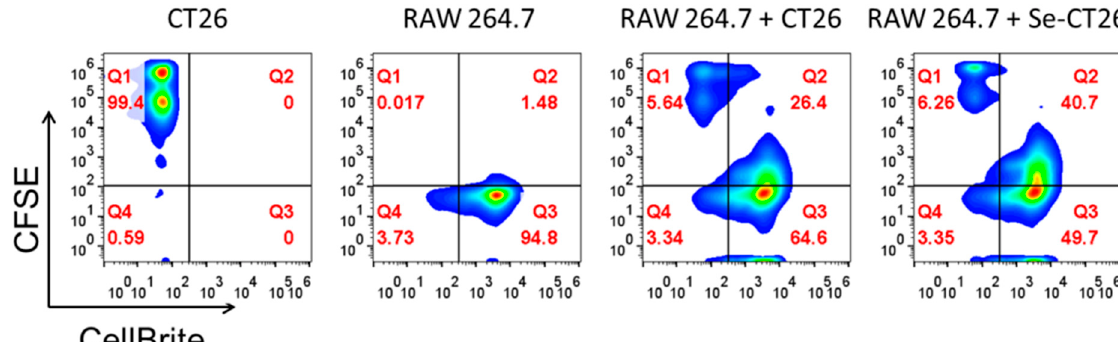
Figure 8. Treatment of CT26 cells with SeNps enhances the phagocytic activity of LPS-stimulated RAW264.7 macrophages against CT26-derived cellular debris. Flow cytometric quantification of phagocytosis of SeNps-treated CT26 cells by RAW264.7 macrophages. CT26 cells were labelled with CFSE prior to SeNps treatment (15 µ g/mL, 48h). Treated CT26 cells and cellular debris were collected and co-cultured for 3 h with LPS-stimulated and CellBrite red-labelled RAW264.7 macrophages (RAW264.7 + Se-CT26). Moreover, RAW264.7 macrophages were co-cultured with the controls, untreated CT26 cells (RAW264.7 + CT26). Cells were collected and analysed on an Attune NxT flow cytometer. CT26 and RAW264.7 cells were also individually analysed (CT26 and RAW 264.7). An enhanced phagocytic activity was observed in macrophages co-cultured with SeNps-treated CT26 cells when compared to macrophages co-cultured with untreated control CT26 cells, evident by the elevated ratio of the double positive fraction in the analysed cell population (40.7% in RAW264.7 + Se-CT26 compared to 26.4% in RAW264.7 + CT26). Results are representative of three independent experiments.